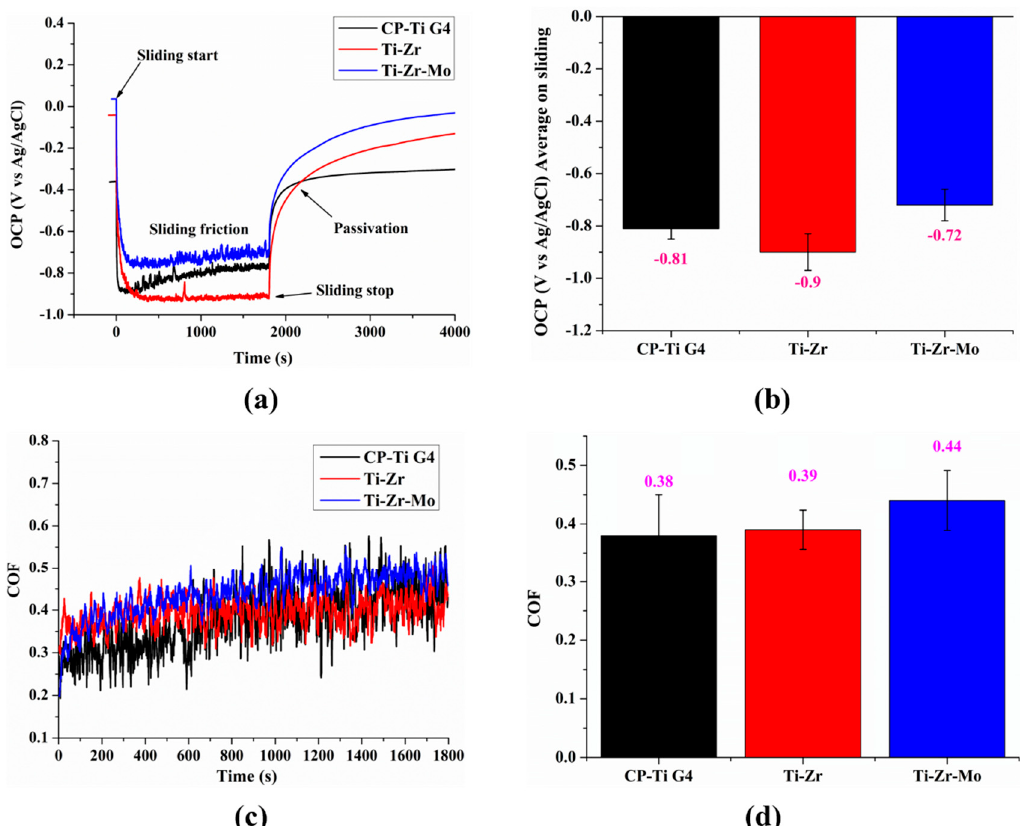
Figure 8. ( a ) open-circuit potential (OCP vs. Ag/AgCl) before, during, and after tribocorrosion tests, of all the investigated alloys. ( b ) bar plots of average values on sliding. ( c ) coefficient of friction (COF) during sliding. ( d ) bar plots of COF average.